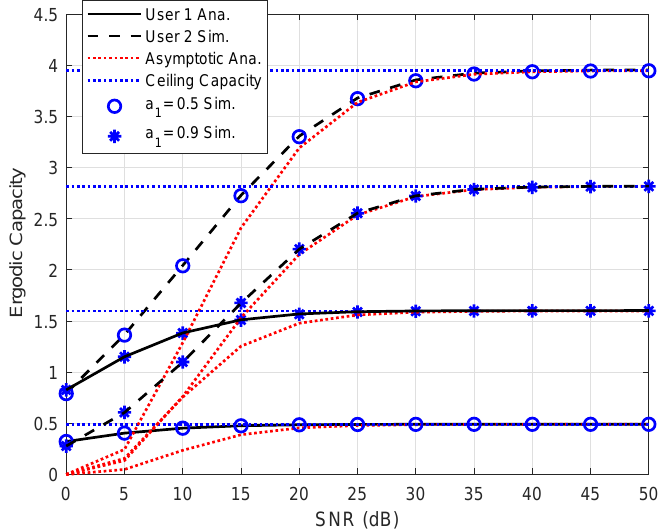
Figure 6. Ergodic capacity of User 1 and User 2 versus SNR.